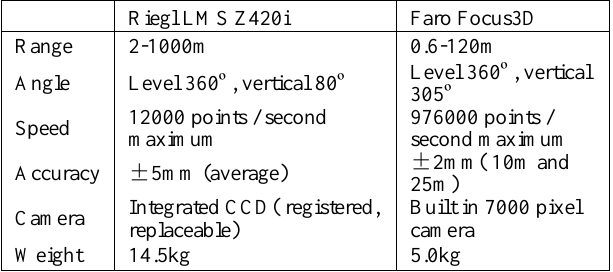
Table 1. Main parameters of the two instruments